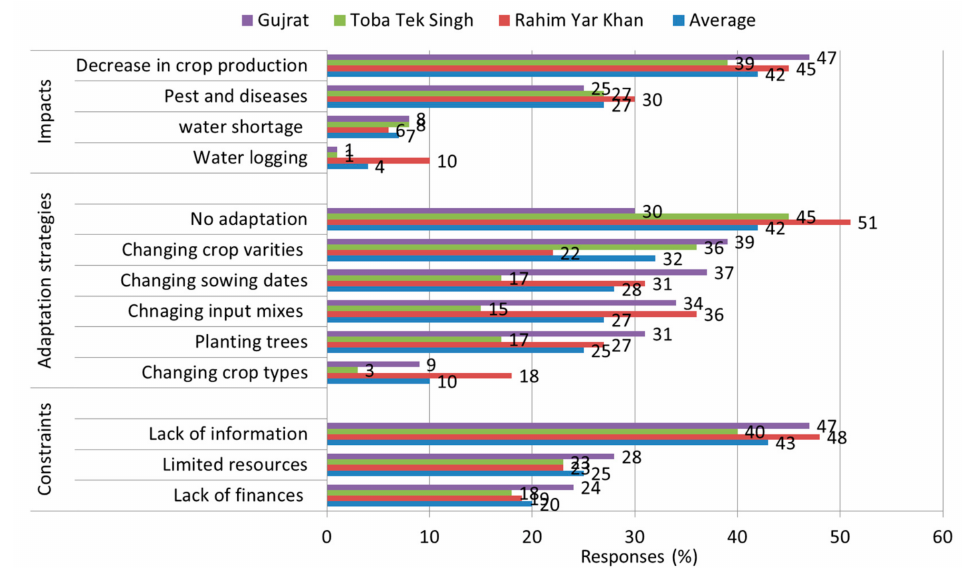
Figure 2. Climate change impacts, adaptation strategies and constraints in the study